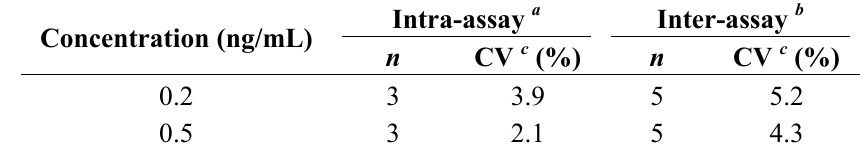
Table 3. Intra- and inter-assay variation for MC-LR